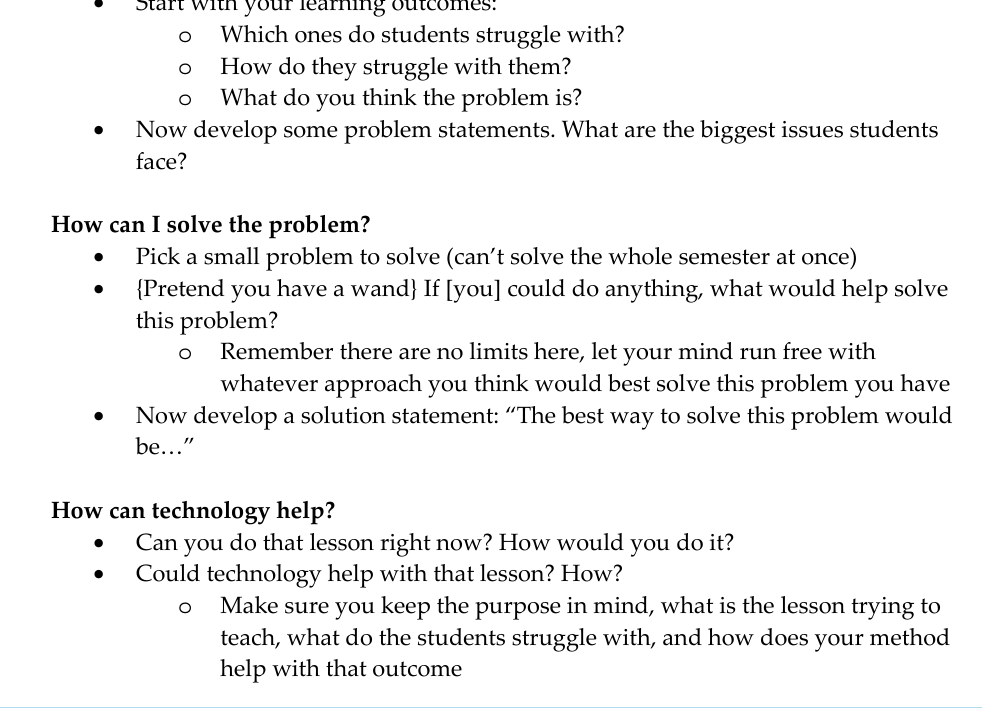
Figure 4. Pedagogy Before Technology worksheet for educators and educational designers.